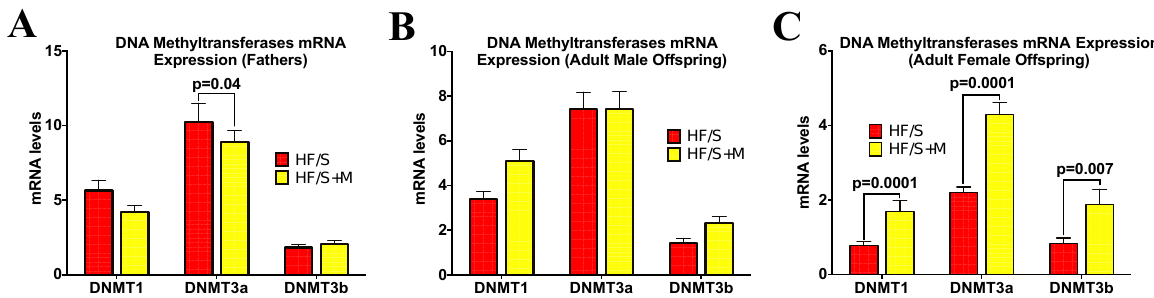
Figure 3. The adipose tissue mRNA levels of DNA Methyltransferases (DNMTs) in ( A ) fathers, ( B ) adult male offspring and ( C ) adult female offspring. The values are means ± SEM, n = 8–13. Sex differences were observed in DNMT1 ( p = 0.0001), DNM3a ( p = 0.0001) and DNMT3b ( p = 0.03); therefore, subsequent analysis was performed in males and females